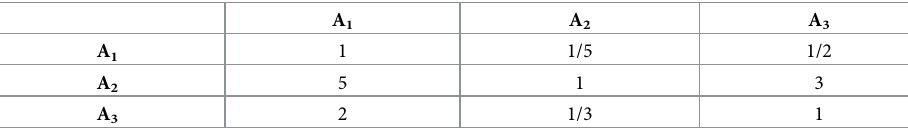
Table 6. Pairwise comparison matrix of the primary indexes.